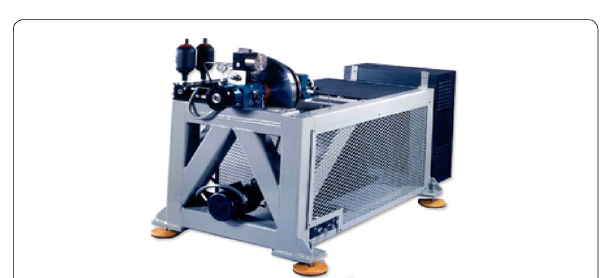
Figure 5 TEAM engine simulation system